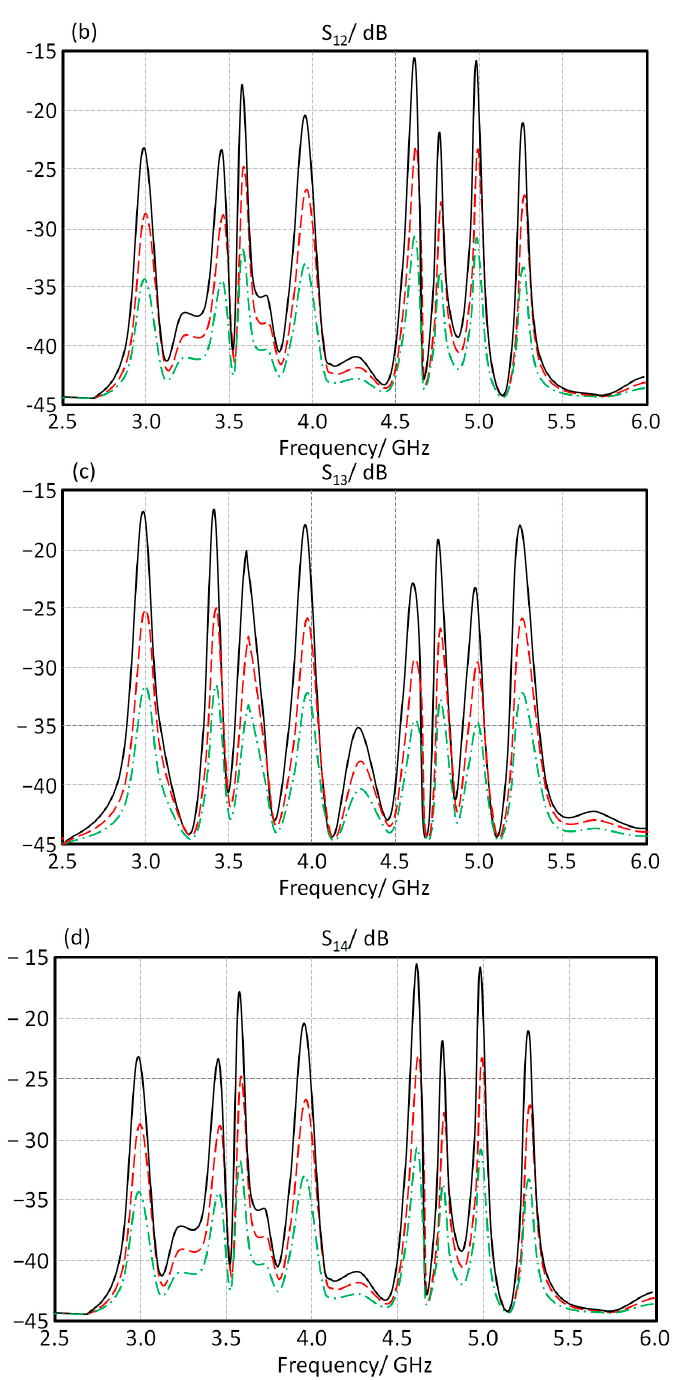
Figure 6. Coupling effects of 3D array configuration in terms of: ( a ) Antenna array model ( b ) S12, ( c ) S13, and ( d ) S14 spectra. Note: The solid black line is for S = 3 mm, the discrete red for S = 6 mm, and the discrete green line for S = 9 mm.